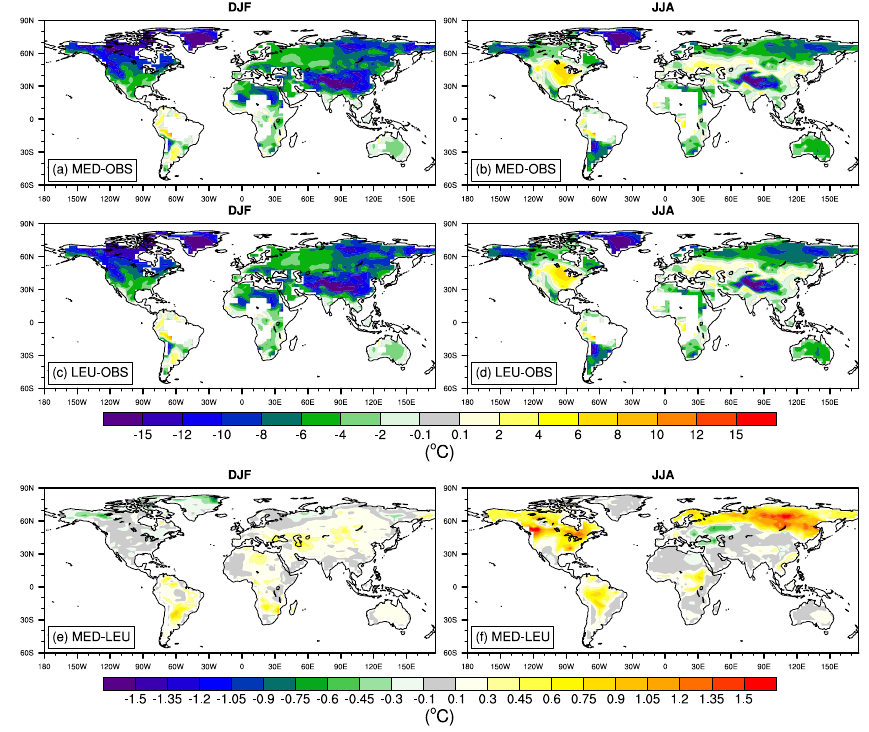
Figure 4. Same as in Fig. 2 except for the warmest maximum ( T Xx ). Observations are from the HadEX2 data set and seasonal means are computed over the period